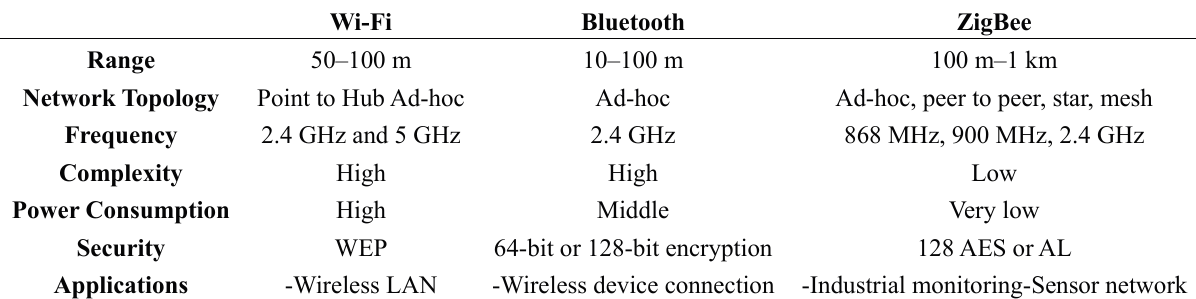
Table 2. Comparison of wireless technology standards.